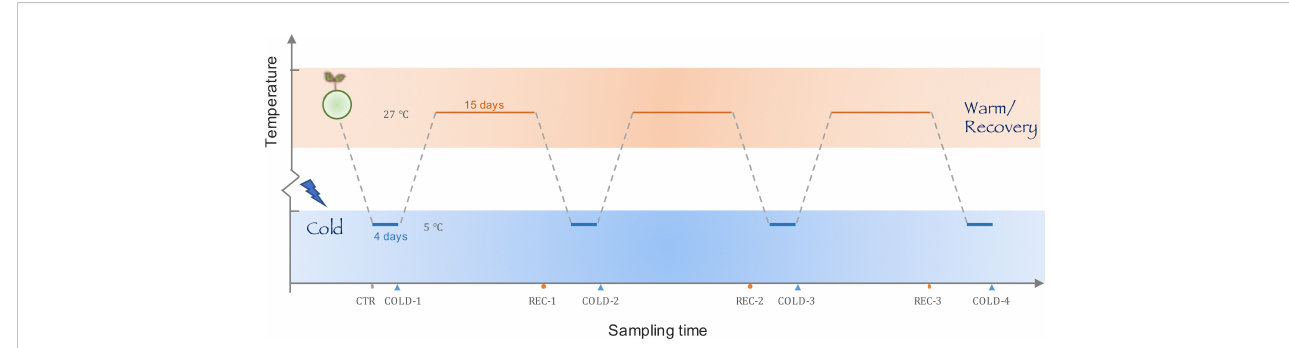
FIGURE 1 The design of the cold wave experiment. We mimicked the typical winter climate on the coast of the north subtropical zones with three cold-recovery cycles, each cycle consisted of a 4-day cold treatment at 5°C and a 15-day recovery treatment at 27°C. Samples for physiological and transcriptome analysis were collected before the cold treatment, and at the end of each cold and recovery